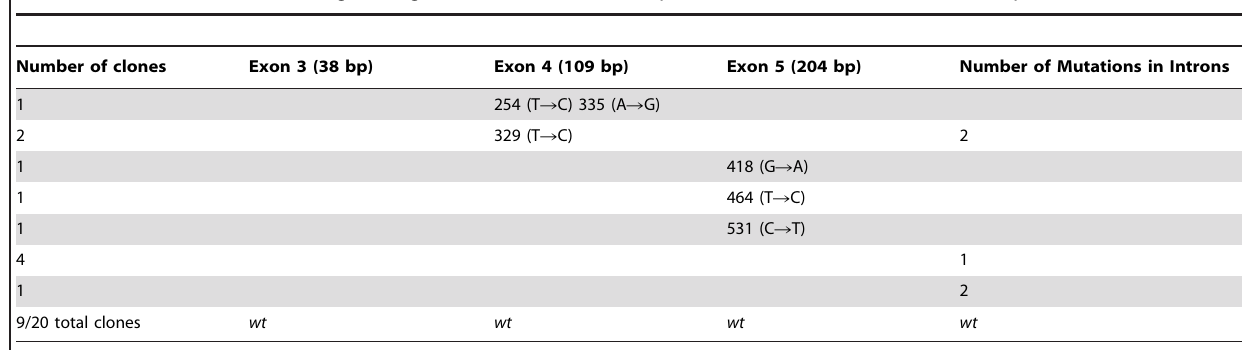
Table 5. Mutations in the G6PD gene region in tumour tissues of patient A, colorectum carcinoma relapse.